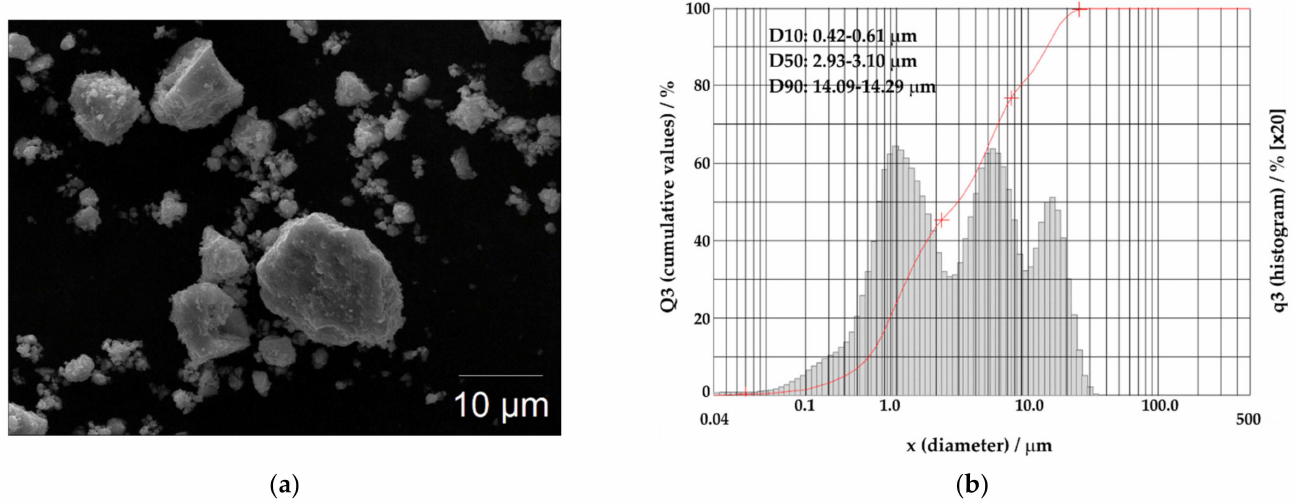
Figure 3. ( a ) SEM image and ( b ) cumulative particle-size distribution and histogram of particle-size distribution of the CuSbS 2 powders directly produced by mechanochemical synthesis.